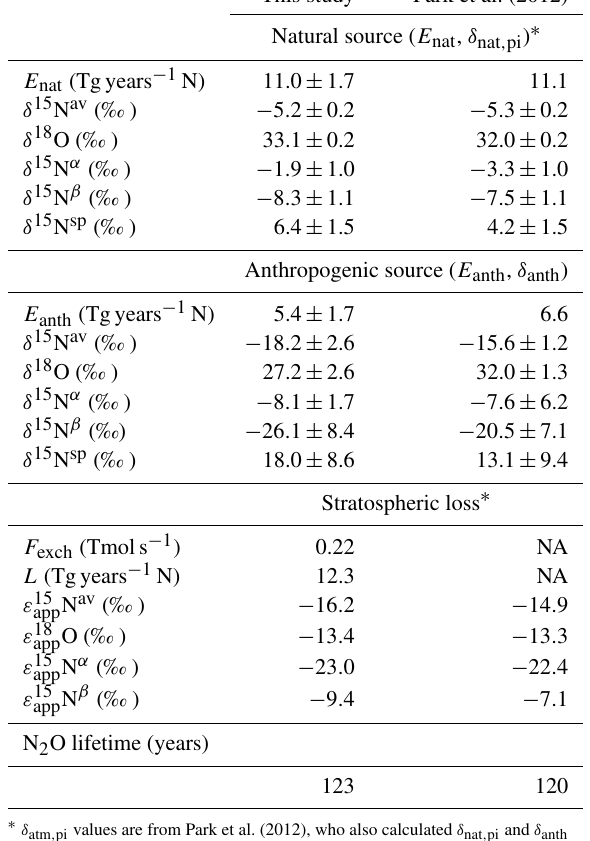
Table 3. Emission fluxes and isotopic composition of the natural and anthropogenic source results from the mass balance model. Stratospheric isotope fractionation ( ε L ) used in the mass balance model, and the respective results from Park et al. (2012). This study Park et al.